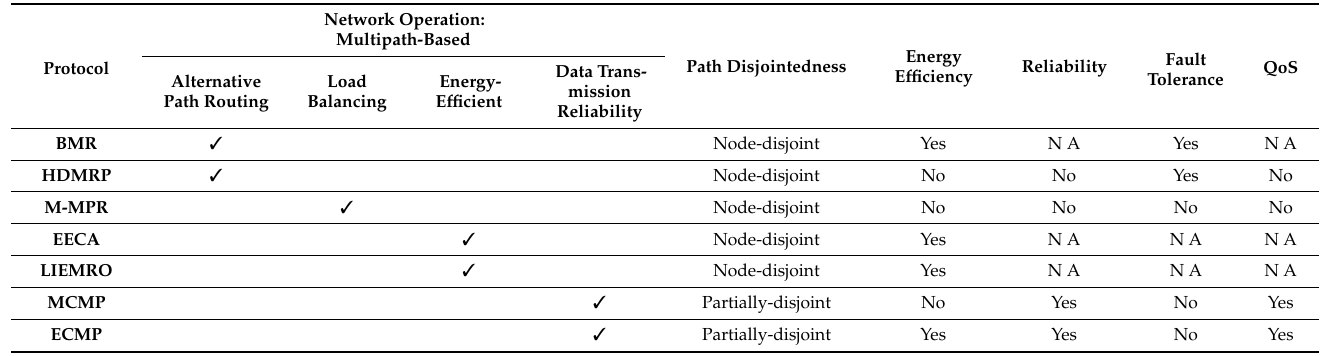
Table 8. Comparison of multipath-based routing protocols for WSNs.